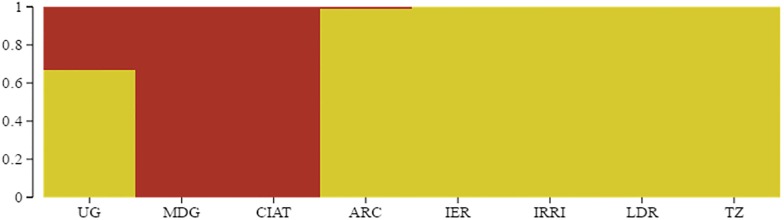
Distribution pattern of 59 rice genotypes based on Bayesian clustering method of DArTseq derived-SNP markers.